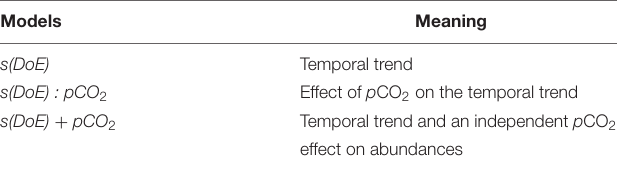
TABLE 1 | Generalized additive mixed model (GAMM)